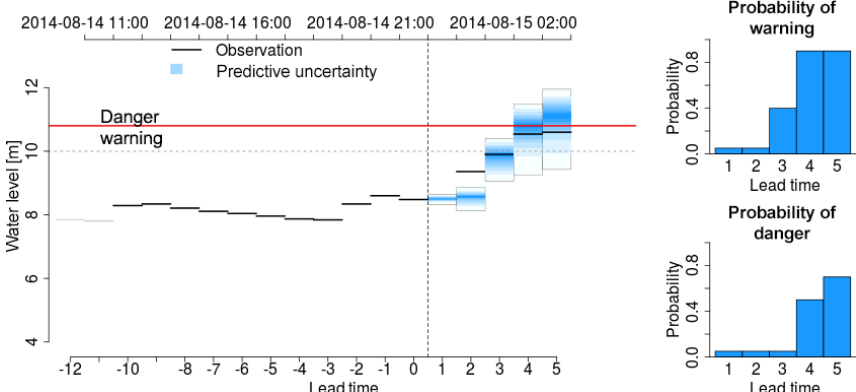
Figure 7. Forecast issued at 23:00LT 14 August 2014 showing on the left the predictions of future water level (blue) and observed data (black). On the right the probability of crossing the respective warning levels at each lead time is